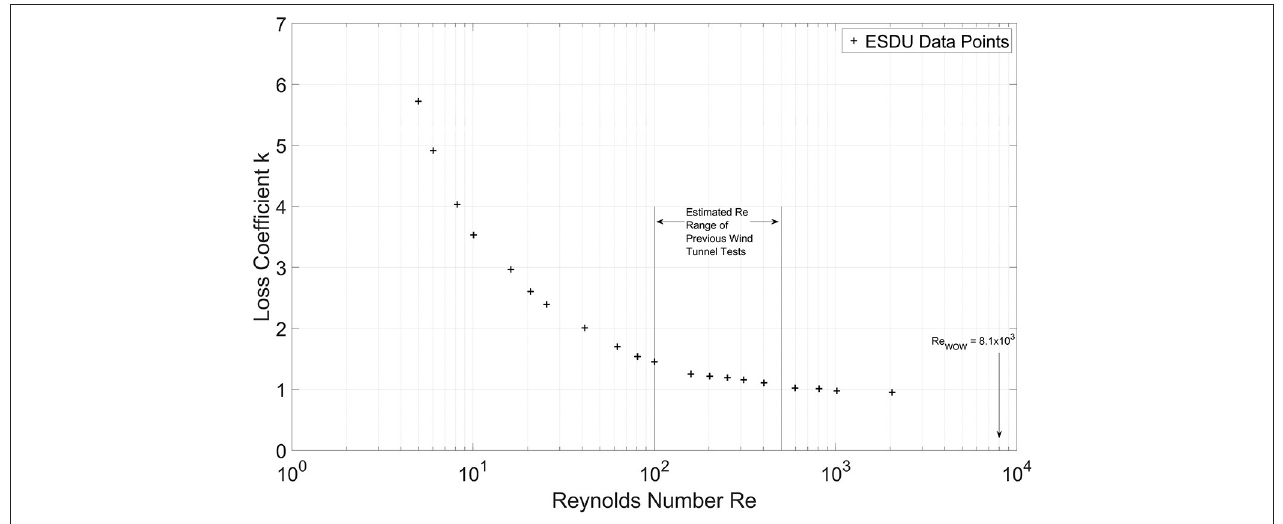
FIGURE 1 | Variation of loss coefficient k with Reynolds number Re